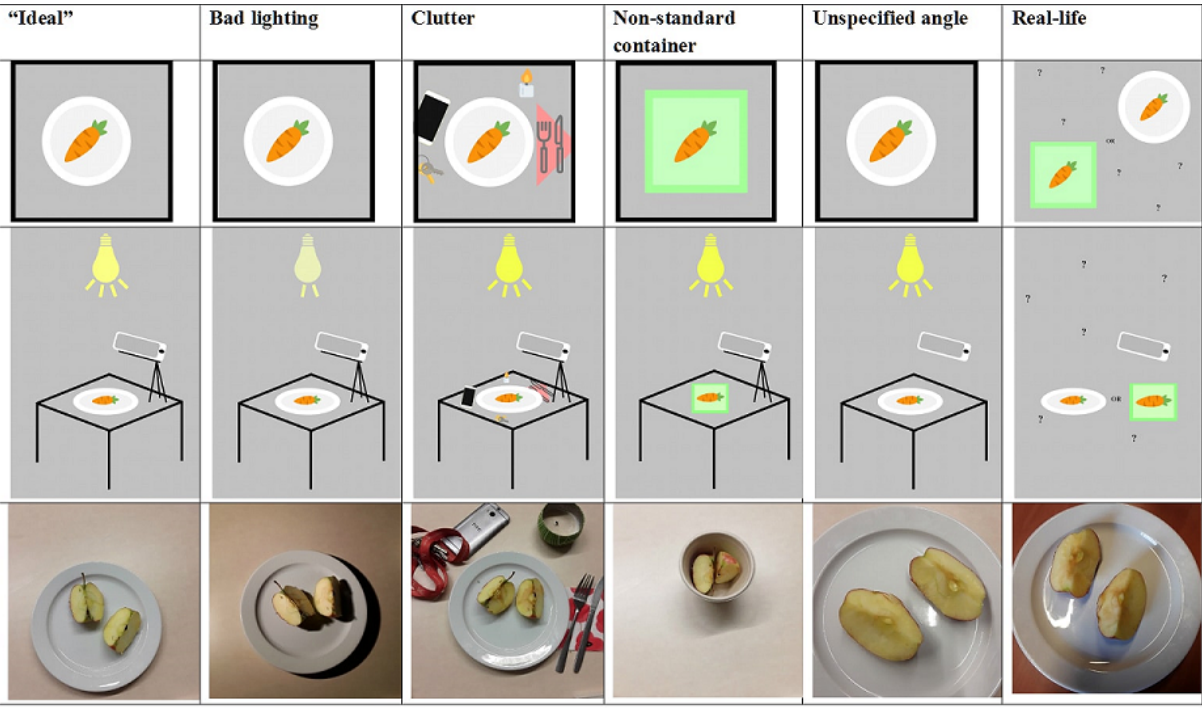
Figure 1. Scheme and example pictures of the photographing settings